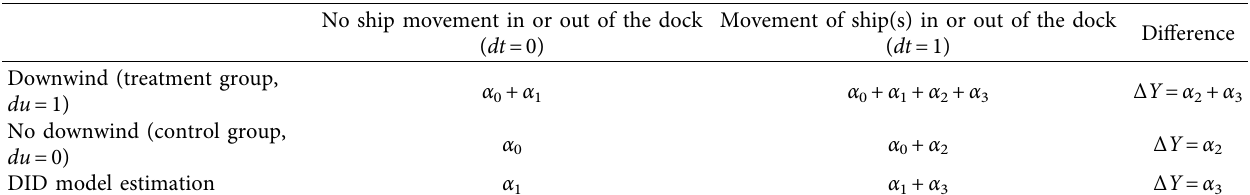
Table 1: DID model parameters.